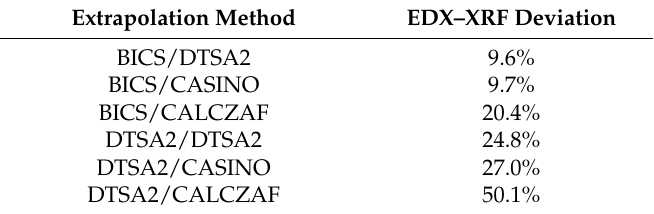
Table 1. List of the deviation from the X-ray fluorescence spectroscopy (XRF) results, in growing order.